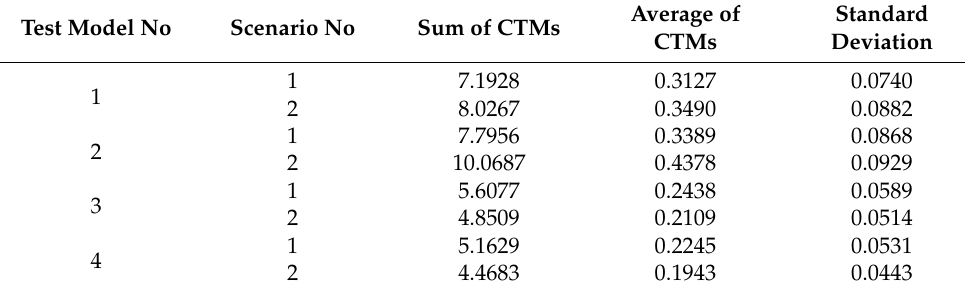
Table 19. CTM comparison of the various test